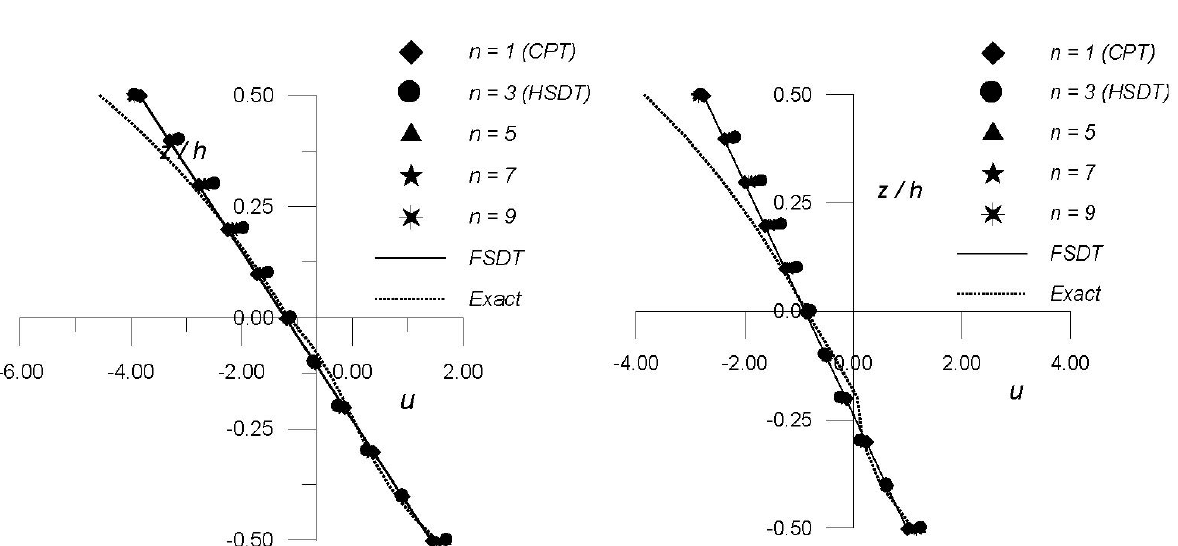
Figure 4: Through thickness distribution of in-plane displacement ( ¯ u ) for simply supported two layered (0 0 /90 0 ) un-symmetrically laminated composite plates with a / h = 4 and E 1 / E 2 =